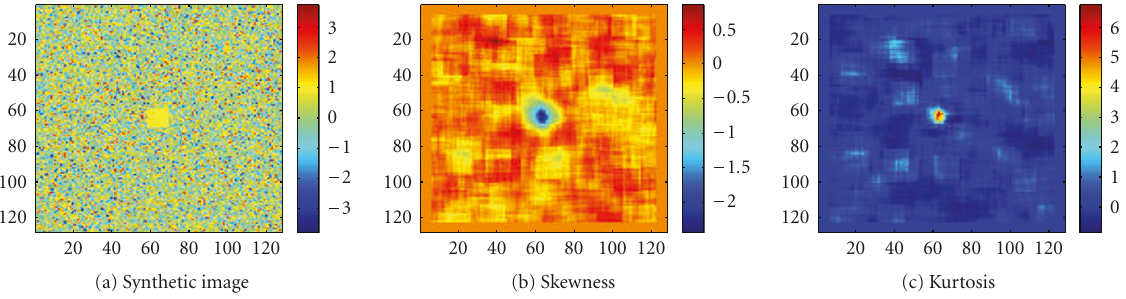
Figure 12: HOS evaluated on 13 × 13 windows (SNR = 0dB).